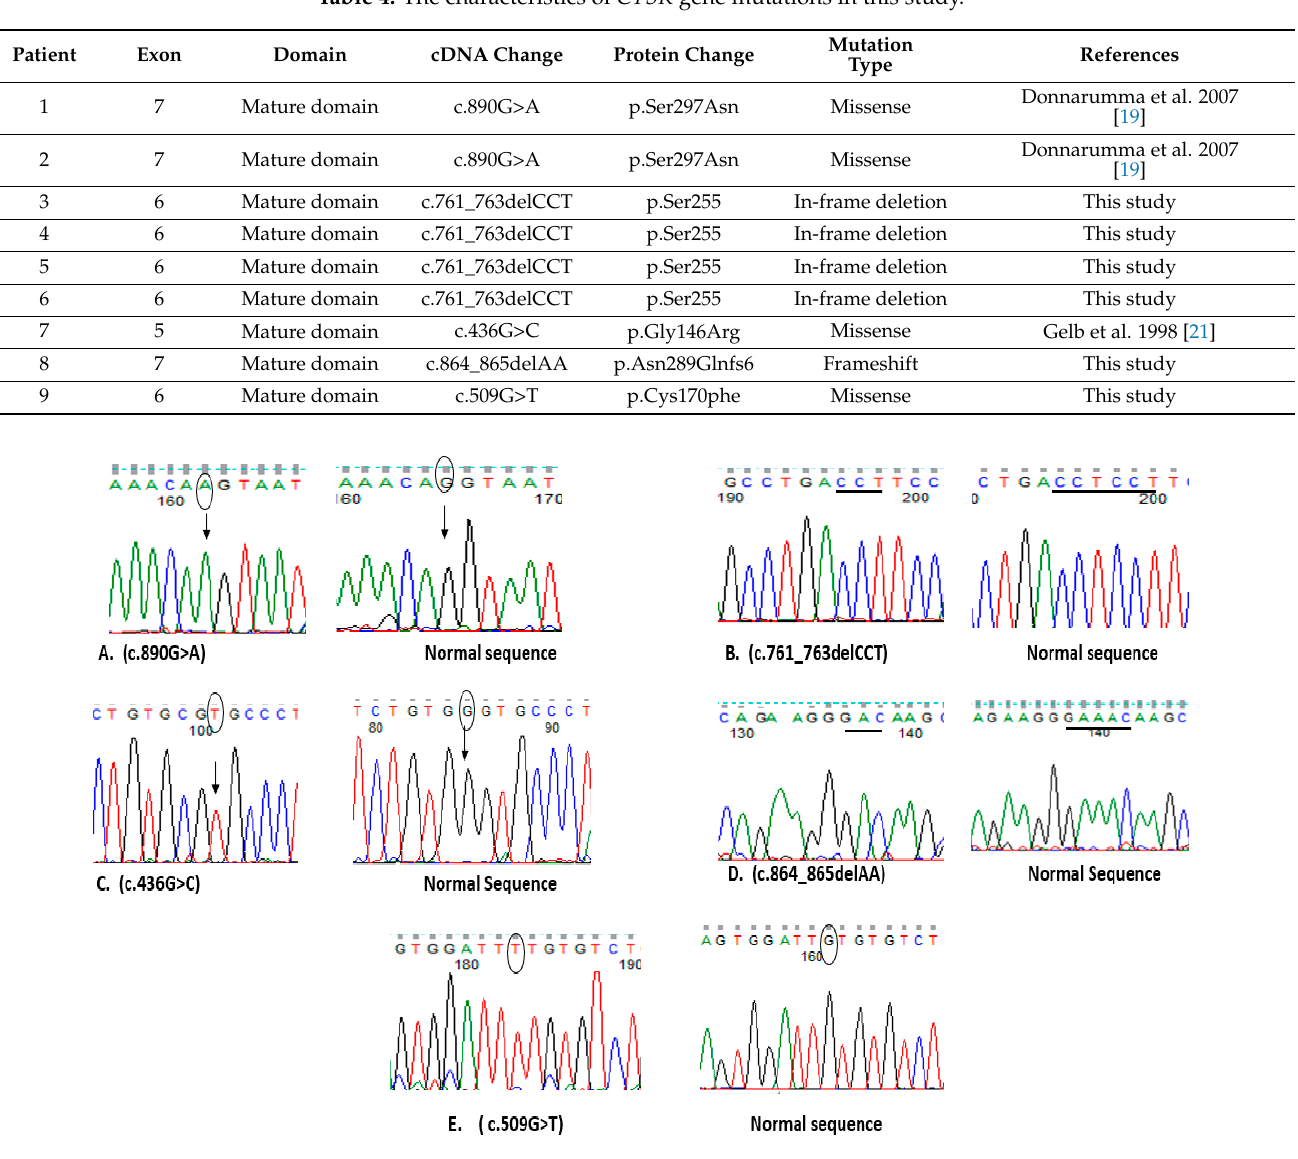
Figure 3. Direct sequencing of CTSK gene obtained from nine patients compared to those from an unrelated normal control. ( A ) c.890G>A was found in patients 1 and 2. ( B ) 3-bp(CCT) deletion at nt 761 was found in patients 3, 4, 5, and 6. ( C ) c.436G>C was found in patient 7. ( D ) 2-bp(AA) deletion at nt 864 was found in patient 8. ( E ) c.509G>T was found in patient 9.